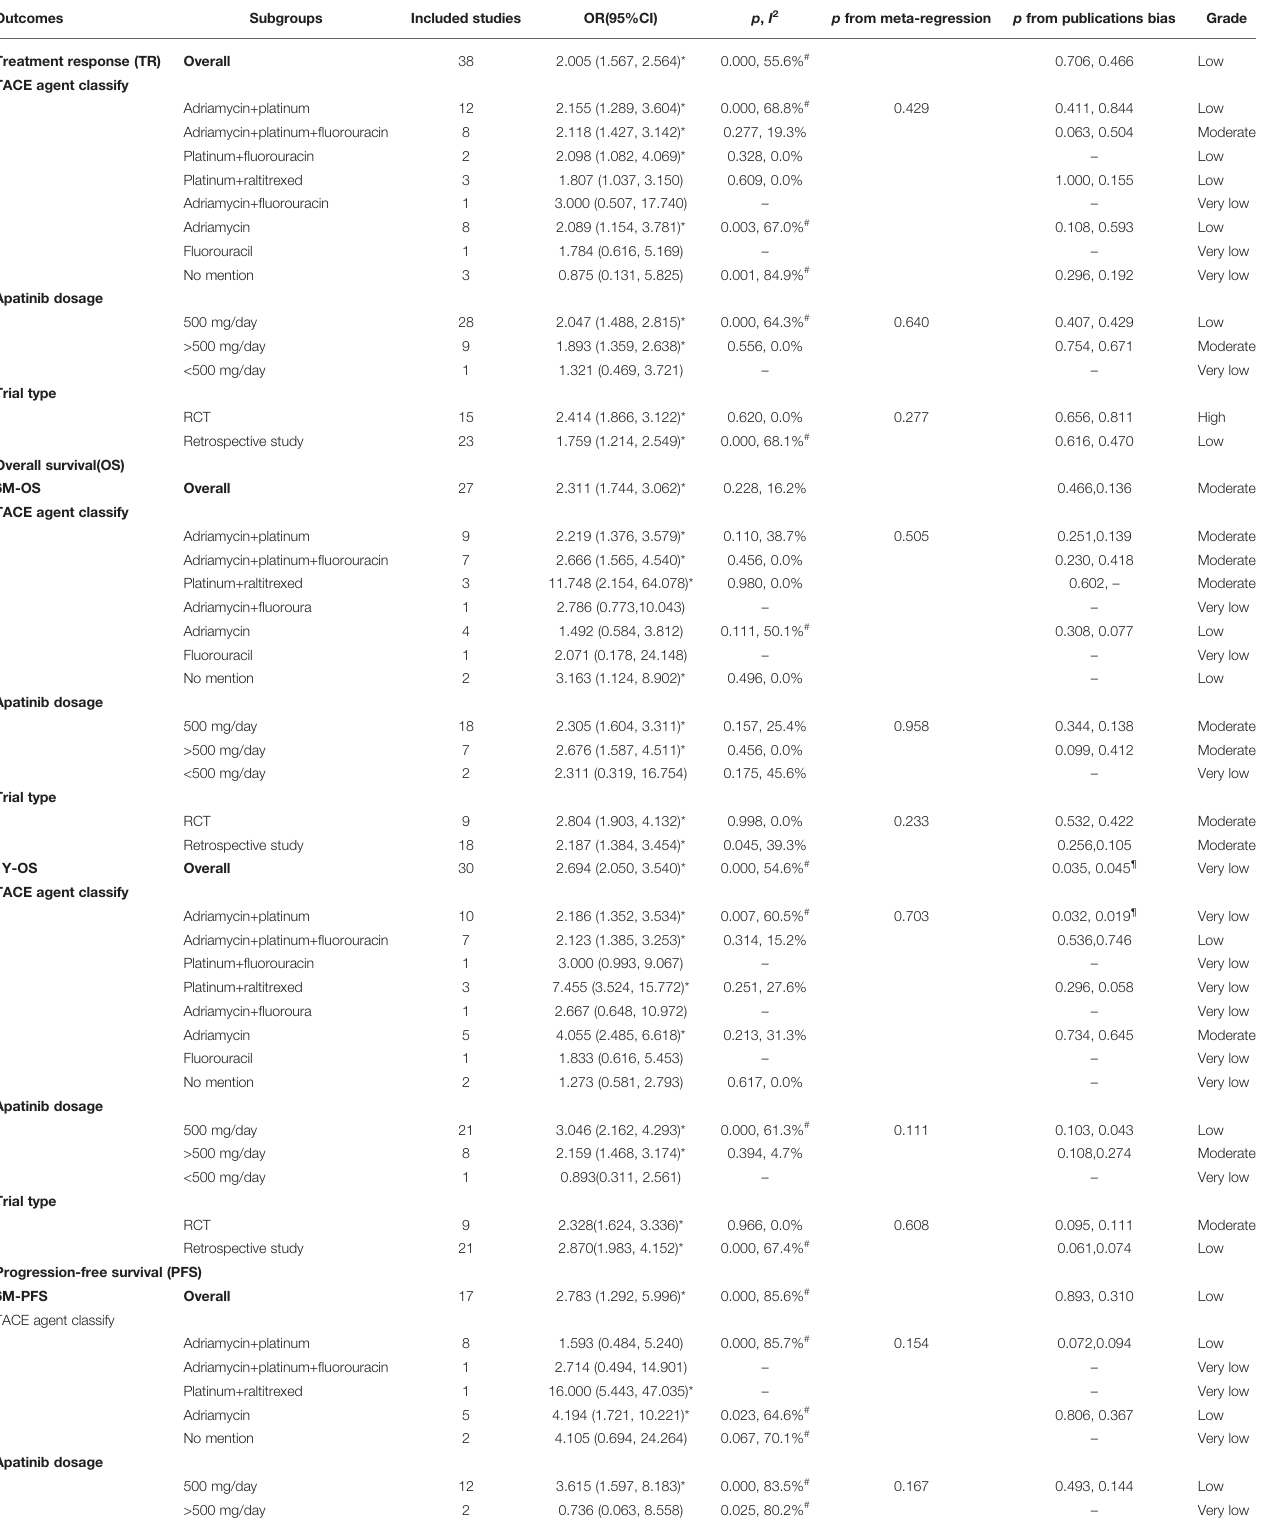
TABLE 2 | Ef fi cacy of TACE+apatinib versus TACE in treatment response, overall survival, progression-free survival, AFP, MMP9, and VEGF, which were analyzed by TACE agent classi fi cation, apatinib dosage, and trial type. Outcomes Subgroups Treatment response (TR)